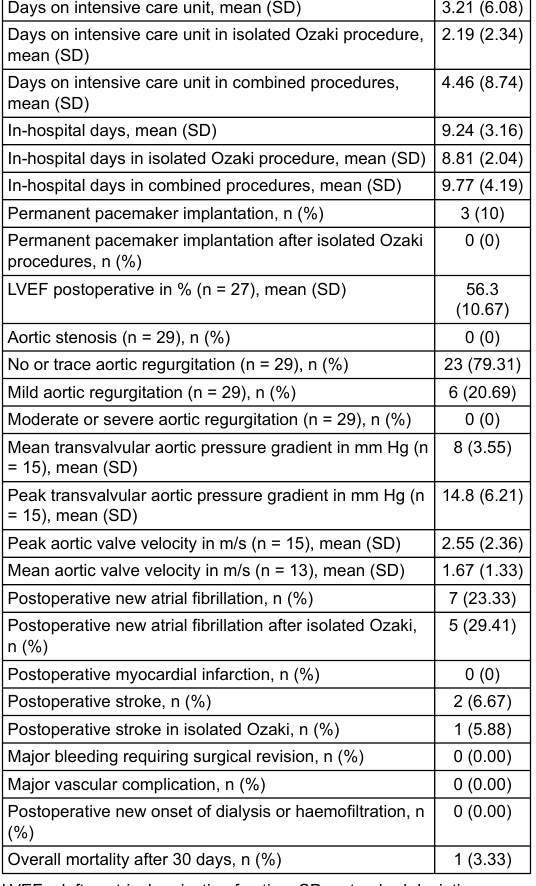
Table 4: Postoperative data (n = 30).